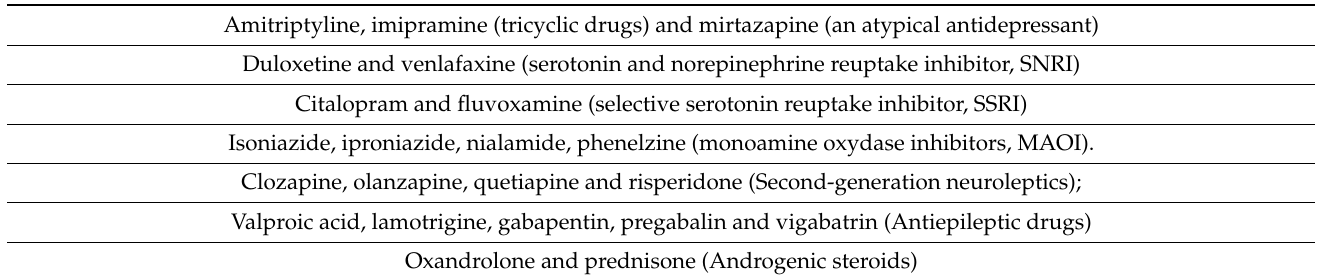
Table 1. Medications stimulating food